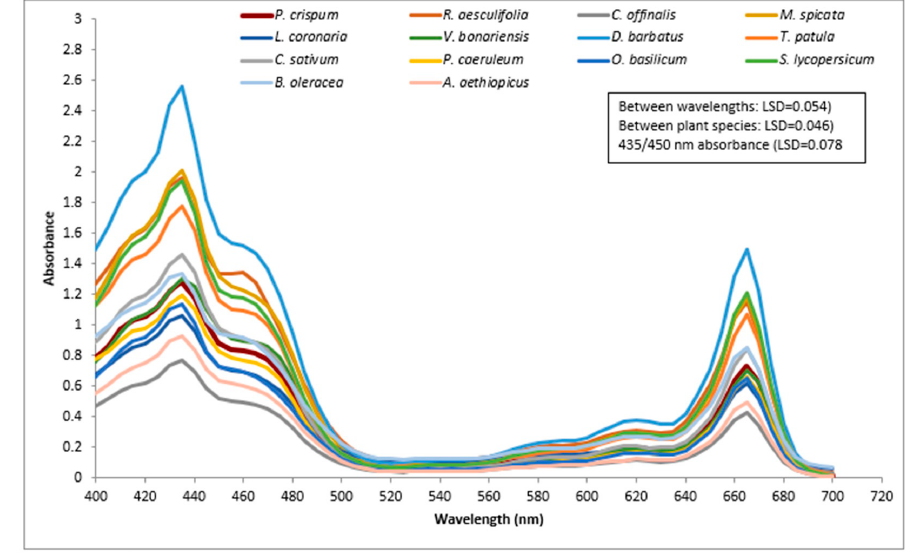
Figure 2. Spectrometric analysis of Calendula officinalis , Mentha spicata , Lychnis coronaria , Verbena bonariensis , Dianthus barbatus , Tagetes patula , Coriandrum sativum (Coriander), Polemonium caeruleum , Ocimum basilicum , Brassica oleracea , Solanum lycopersicum and Asparagus aethiopicus pigment absorption using Jenway 7315 spectrophotometer: Results presented as means